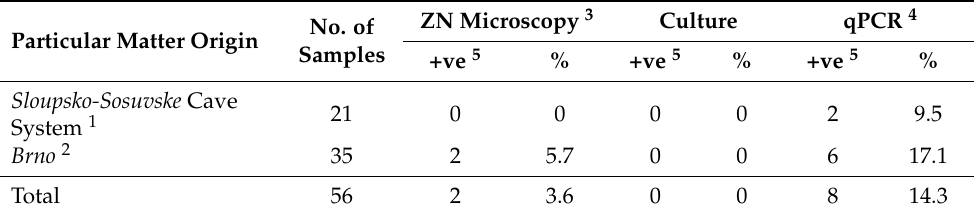
Table interpretation. 1 Sloupsko-Sosuvsky Cave System (location of speleotherapy facility); 2 Brno (collected at the carpark of the Transport Research Centre and on the balcony on the first floor of the Institute of Analytical Chemistry at Veveri Street, Brno , Czech Republic); 3 microscopy examinations after the Ziehl-Neelsen stain- ing; 4 quantitative PCR test, qPCR values on a logarithmic scale between 3 to 4 were considered positive for mycobacterial DNA detection [30]; 5 +ve = positive results. Table 3. Mycobacterial species detection in examined spider’s webs on karst surface and in photic and aphotic zones of caves.